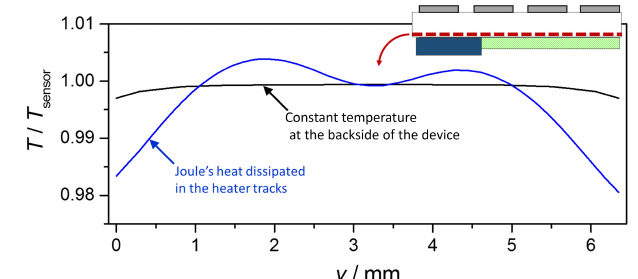
Figure 3. Calculated temperature distribution depending on the overall sensor temperature T sensor on a line across the whole width (6.35mm) of the device on assuming a constant temperature on the reverse side of the device or implementing the heater. The red dotted line in the scheme on the upper right illustrates where the tempera- ture is